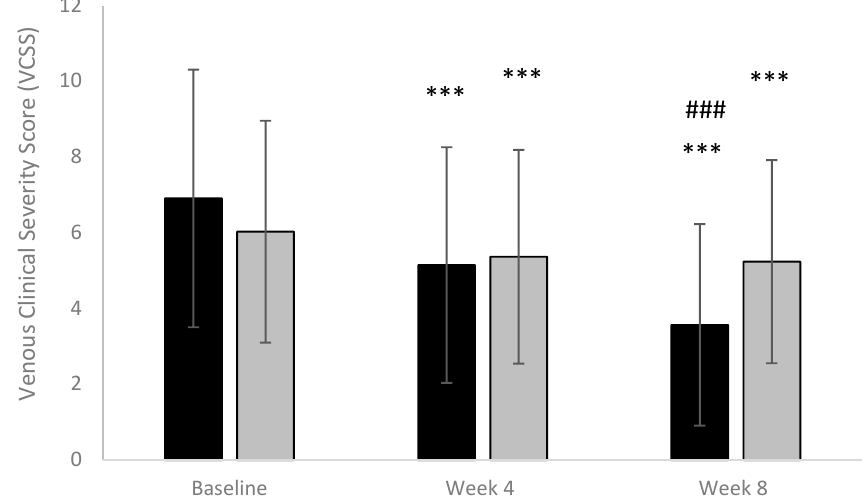
Figure 4. Venous Clinical Severity Score. (Black column: active; Grey column: placebo) *** p < 0.001 vs. baseline; ### p < 0.001 active vs. baseline.